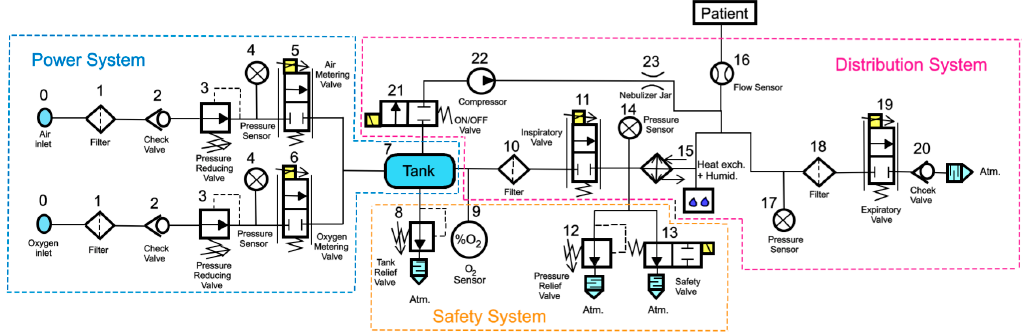
Figure 12. Pneumatic scheme of a typical ventilator for ICUs with ISO symbols.